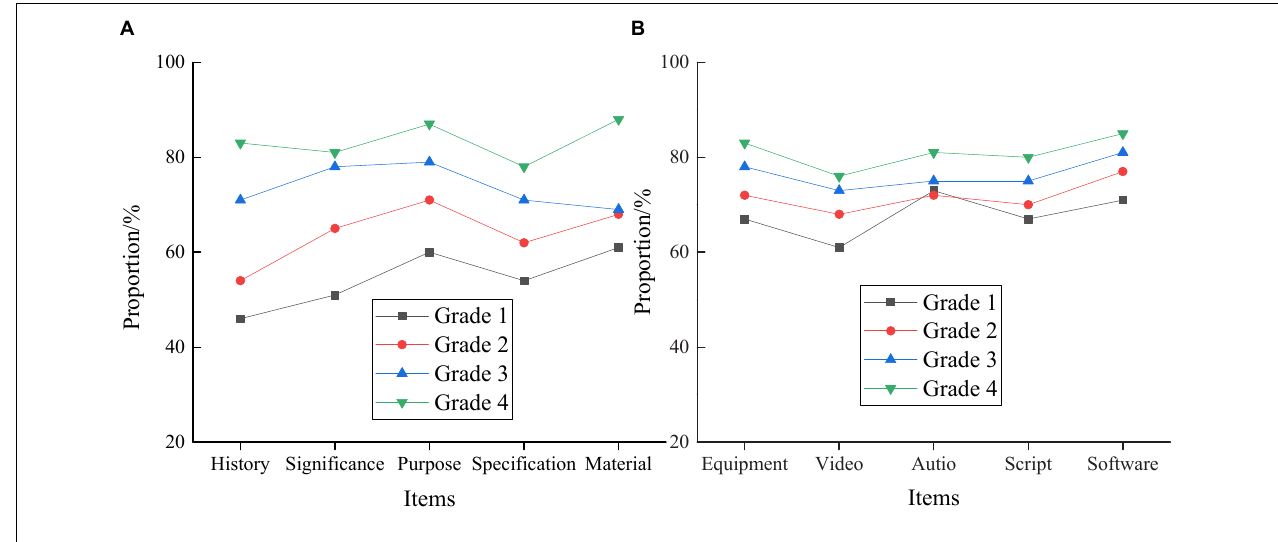
FIGURE 5 | Evaluation results of different grades. (A) Theoretical knowledge. (B) Creative